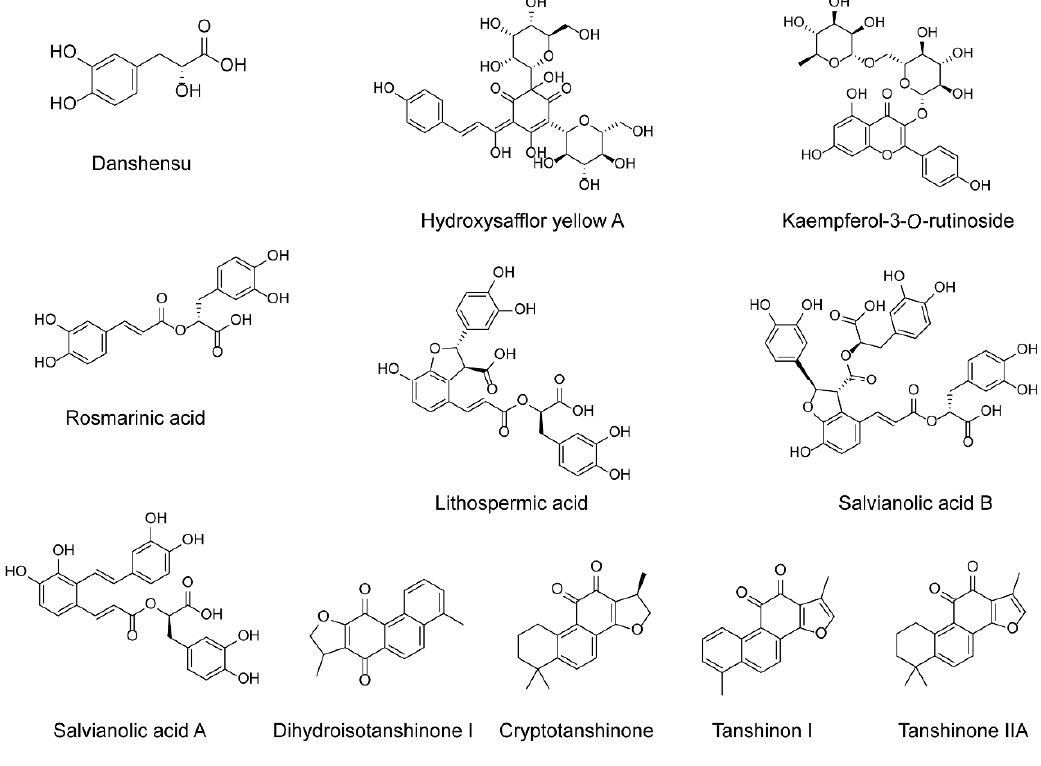
Figure 4. Chemical structures of 11 potential active components in the DH herbal pair.